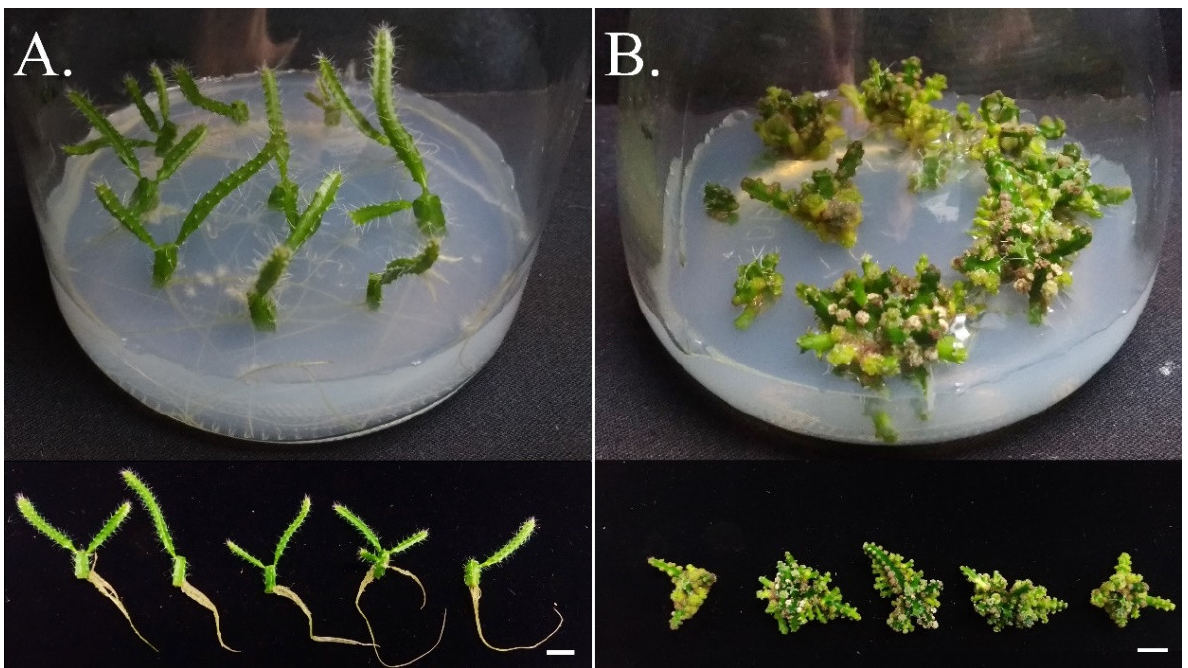
Figure 1. In vitro plantlets of Hylocereus polyrhizus ‘Da Hong’ after 5 months of incubation ( A ) on Murashige and Skoog (MS) medium and ( B ) with 2.00 mg/L 6-benzylaminopurine (BAP). Scale Bar = 1 cm for the plantlets without agar.